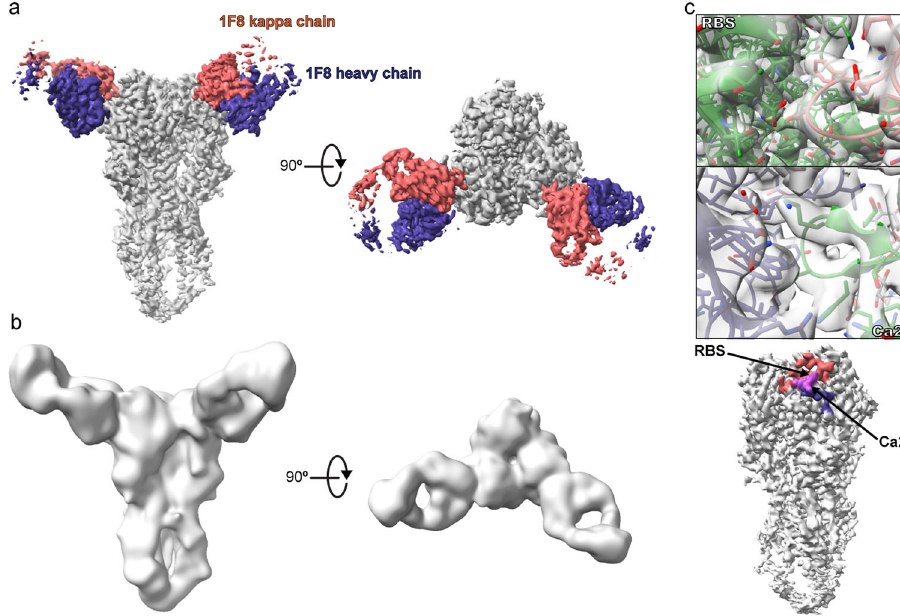
Fig. 5 Cryo-EM structure of COBRA P1 bound to antibody 1F8. a 3D volume of the COBRA P1-1F8 complex, colored based on protein identity. b Gaussian fi ltered map (ChimeraX) clarifying the stem domain and constant regions of the Fab. c Closeup views of the epitope recognized by 1F8 (top) and overview of the antibody binding footprint (bottom). Regions of the footprint in HA that contact the light chain, heavy chain, or both are colored salmon, purple, or magenta,